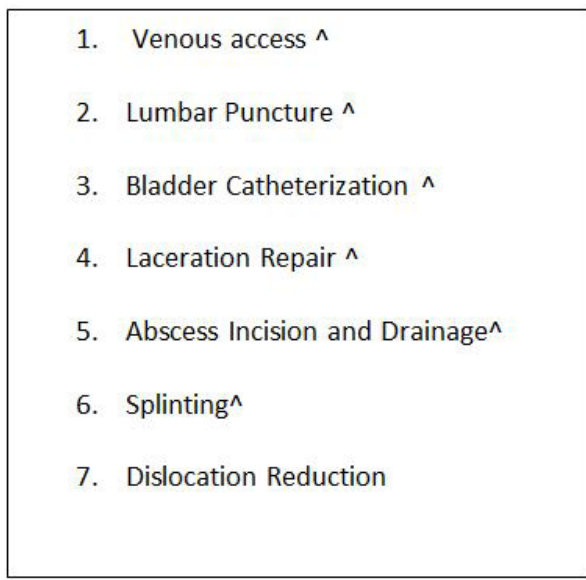
Figure. Procedures to which students should have exposure during pediatric emergency medicine course (^Procedures that align with National EM Curricula 1,2